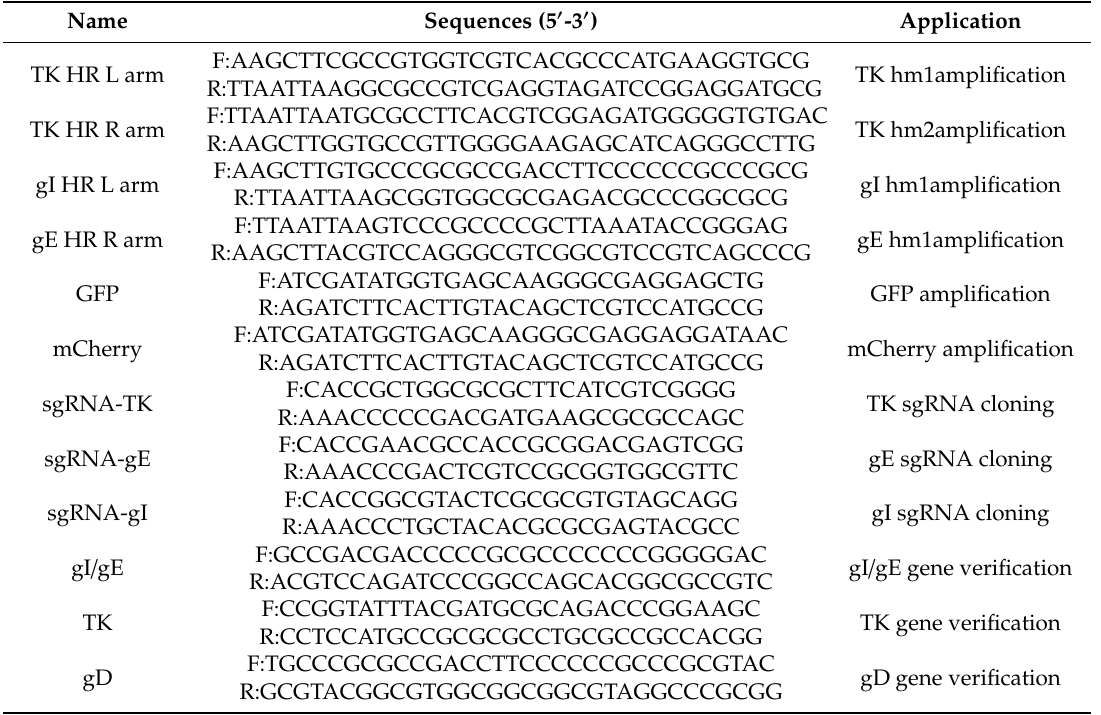
Table 1. Sequences that were used in this